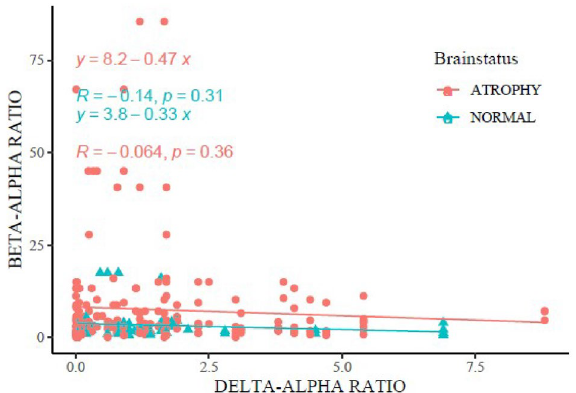
Figure 9. Correlation between Focused Occipital BAR versus DAR. In both atrophy and normal subjects, BAR shows insignificant correlation despite a trend towards children with normal brain